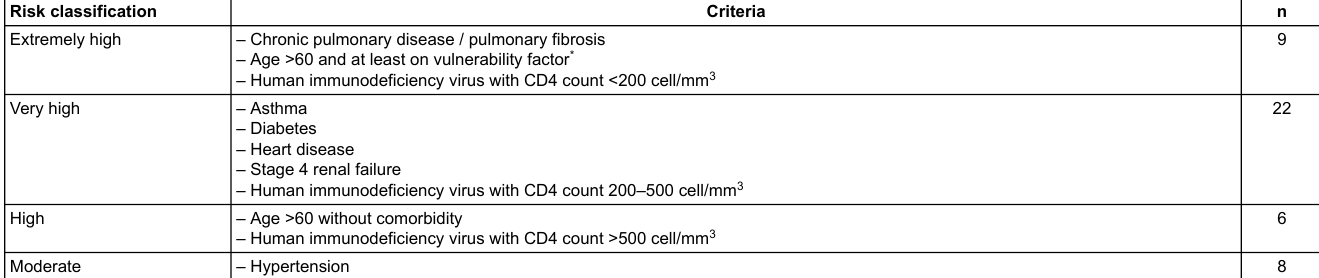
Table S1: Criteria for COVID-19 Vulnerability and Risk Classification used by the Penitentiary Medicine Service of the Geneva University Hospitals (on 15 March 2020). Risk classification